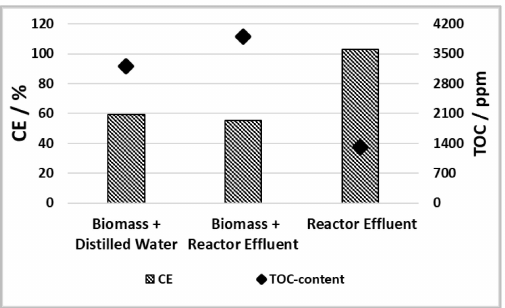
Figure 6. Carbon efficiency and TOC content of reactor effluent of gasification experiments with Reed Canary Grass for three different feeds.